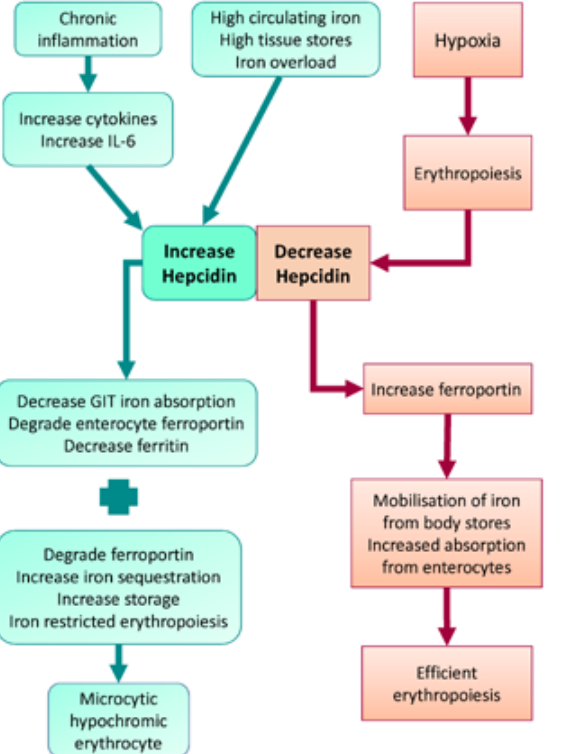
Figure 1: Hepcidin regulates iron absorption and mobilisation from internal stores, and is increased in chronic inflammatory disease states.